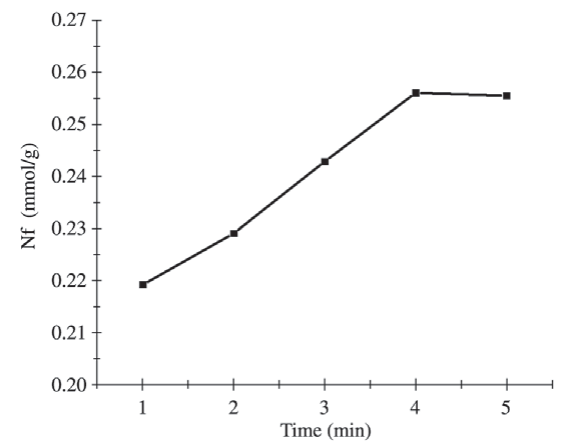
Figure 2. Plots of N versus time for Cu(II) from na aqueous solu- f tion at room temperature